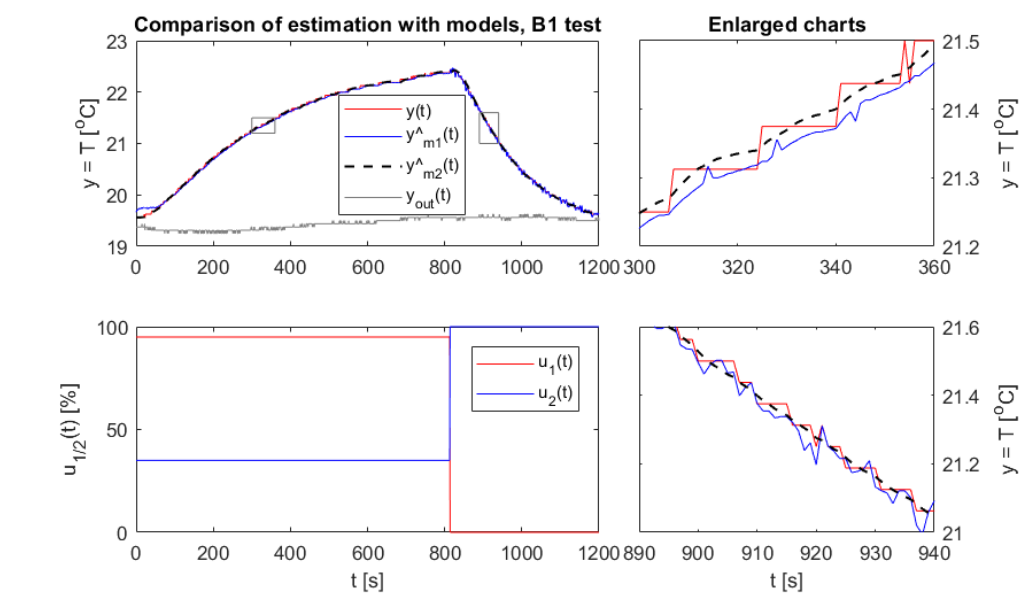
Figure 6. Experimental results for 1000 particles; the measured value (red), estimated values from assumed models (blue and black), and outdoor measurement (gray); and the input signals.